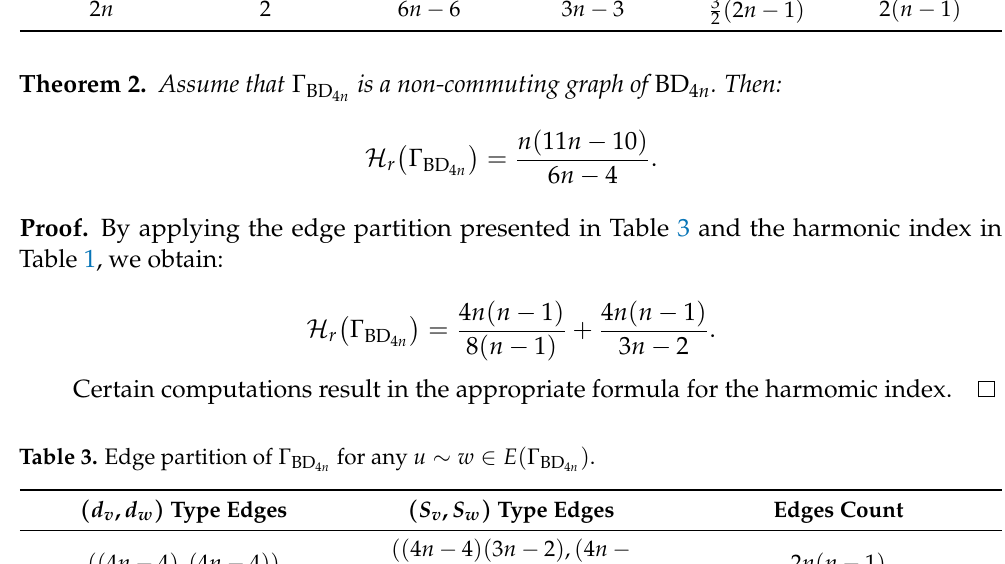
for any u ∼ w ∈ E ( Γ BD 4 n